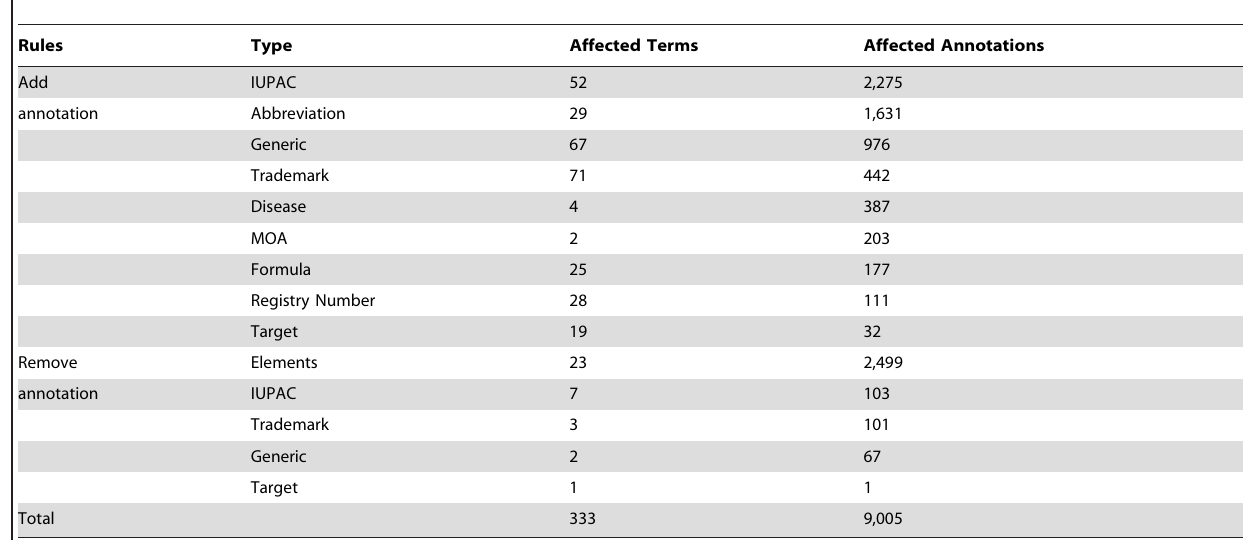
Table 4. The effect of the disambiguation process on the